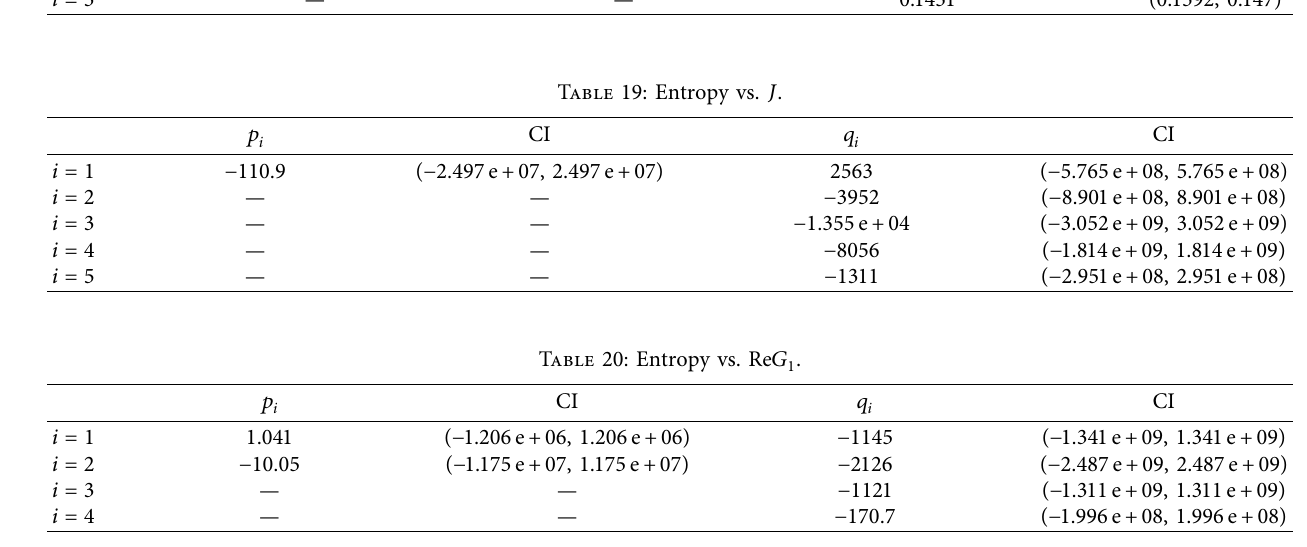
Table 21: Entropy vs. Re G